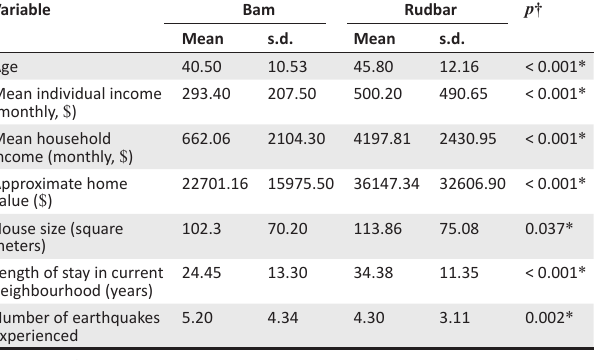
TABLE 3: Comparison of demographic, social and economic characteristics between Bam and Rudbar cities (continuous variables). Variable